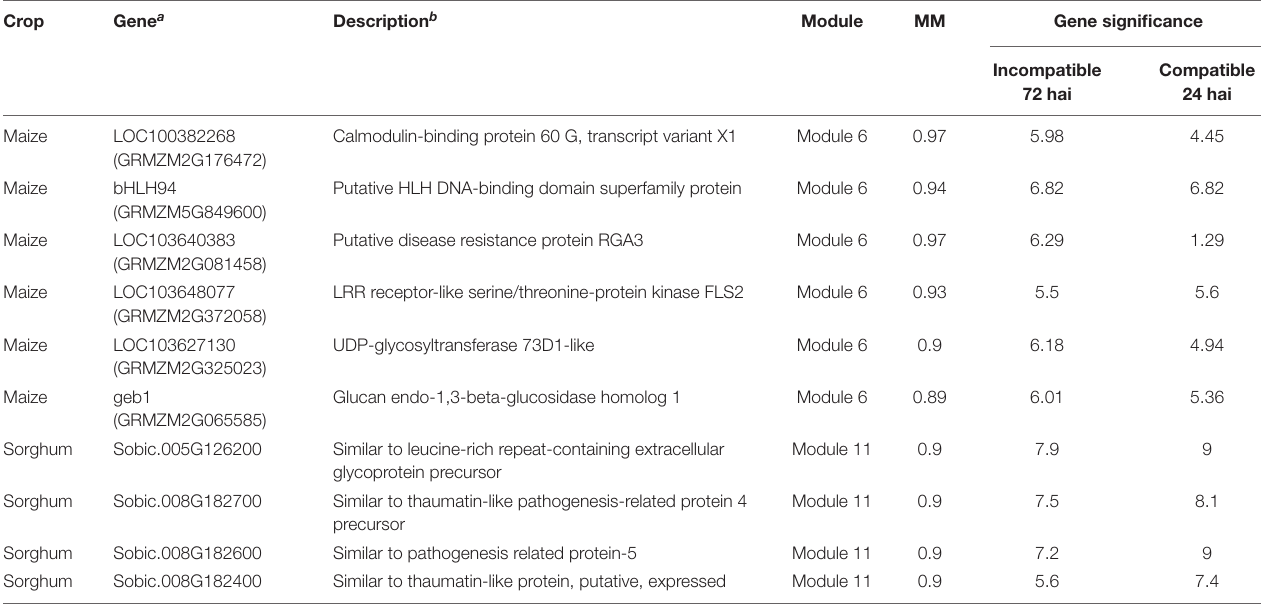
TABLE 4 | Hub genes in maize module 6 and sorghum module 11 based on module membership (MM) and gene significance. Crop Gene